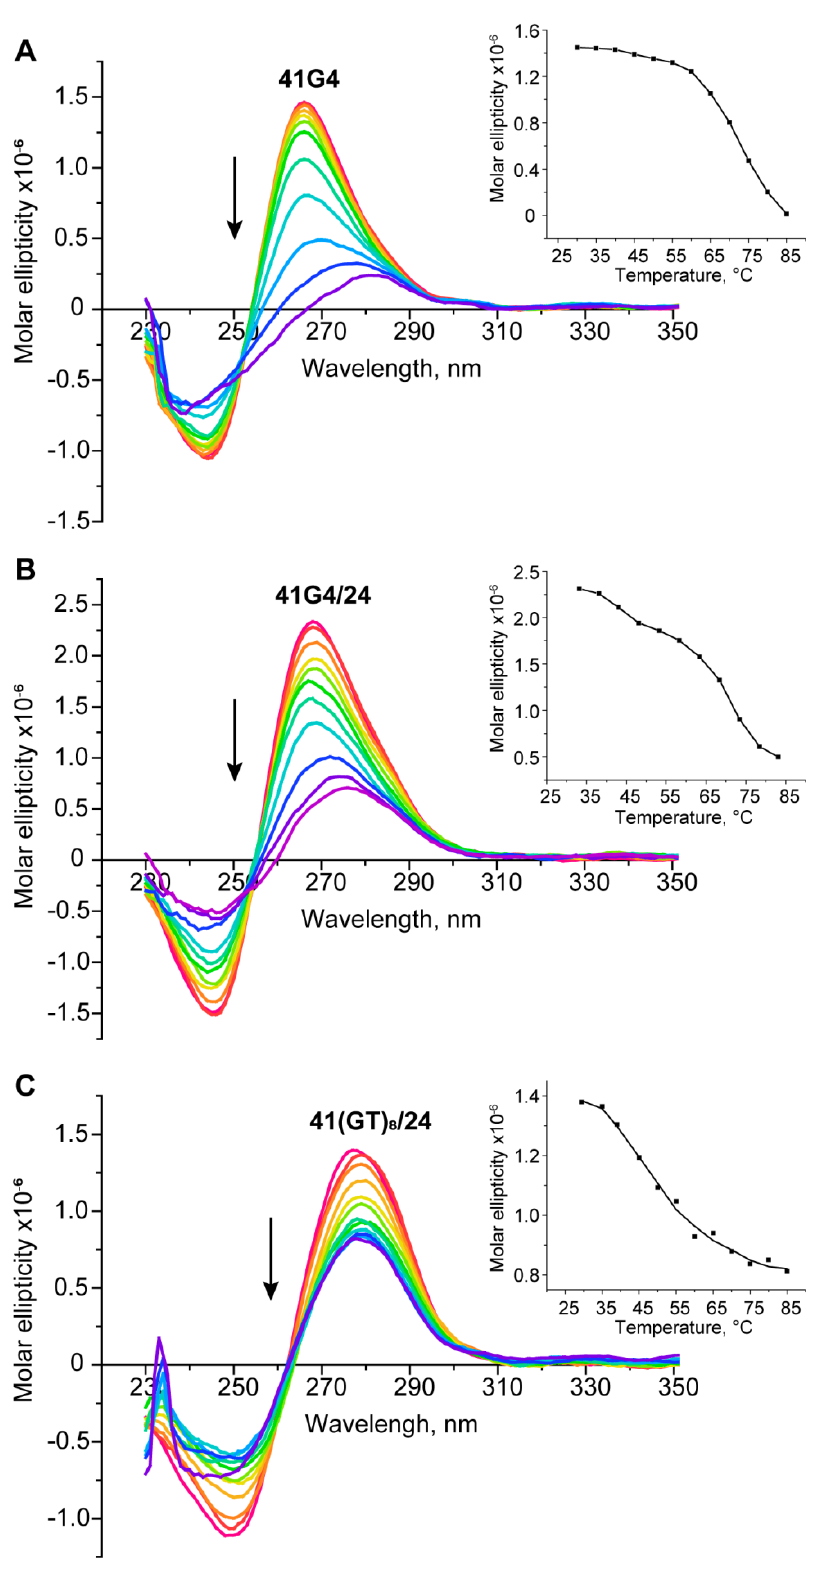
Figure 6. CD spectra of single- and double-stranded DNA models as recorded in buffer A at different temperatures (~2 µM oligonucleotide strand concentration). ( A ) 41G4; ( B ) 41G4/24; and ( C ) 41-(GT) 8 /24. The arrow indicates the temperature increase from 30 to 85 °C in 5 °C increments; multicolor lines show the CD spectra at different temperatures rising along the direction of the arrows. (Insets) CD-monitored melting profiles at the wavelength of an ellipticity maximum.